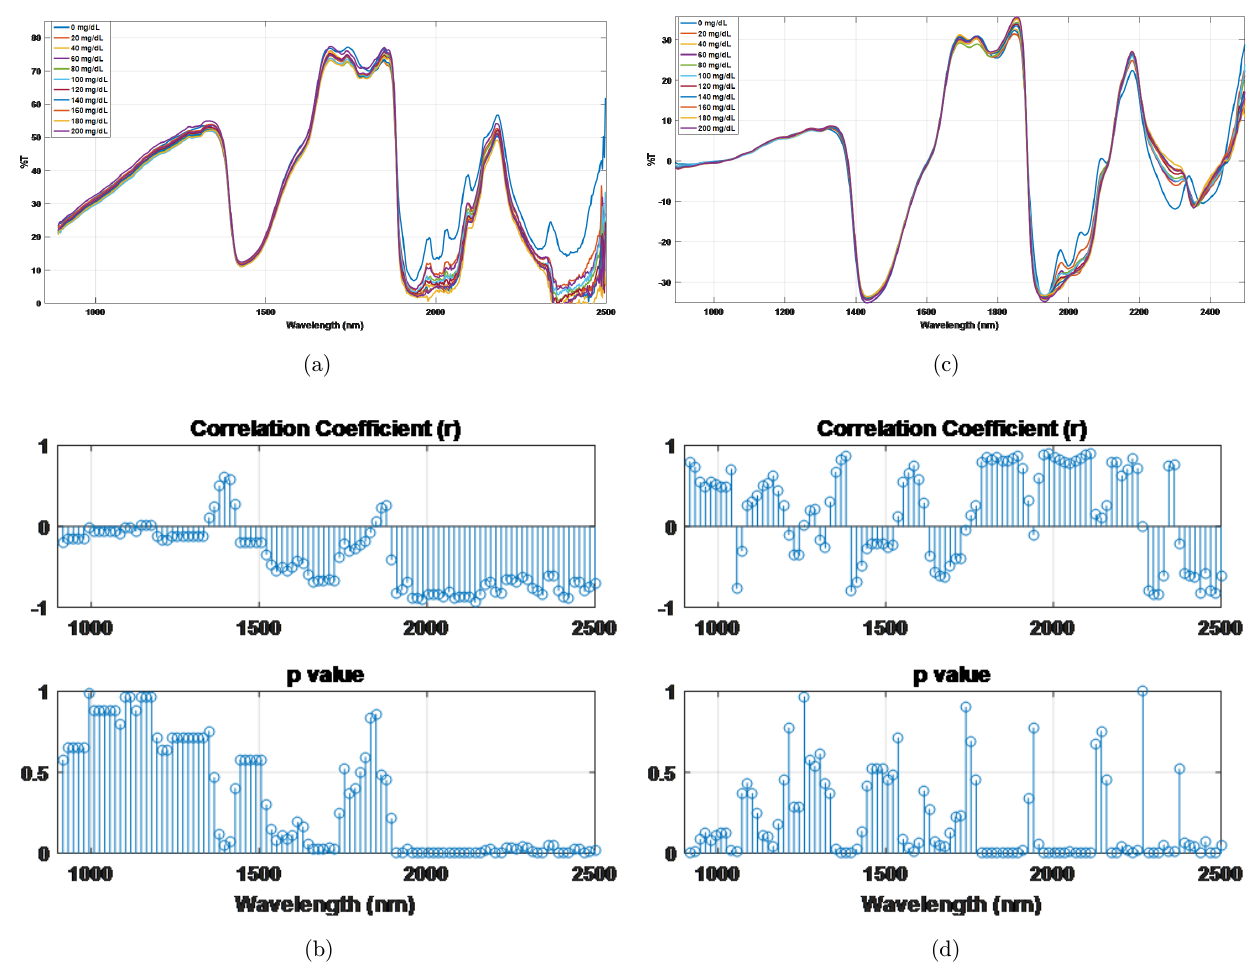
Fig. 7. Di®erent glucose concentrations transmission spectrums of the phantom that has (cid:1) 0 s ¼ 5 : 5 and (cid:1) a ¼ 0 : 1 cm (cid:1) 1 : (a) Raw spectrums. (b) Correlations with glucose. (c) Preprocessed spectrums and (d) Correlations with glucose.